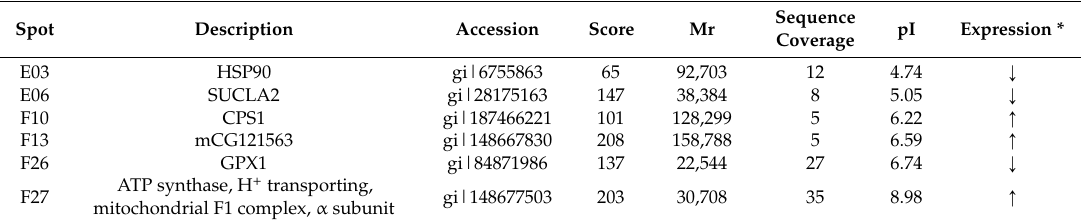
Table 2. Differentially-expressed proteins in hepatic mitochondria of mice fed an excessive selenium